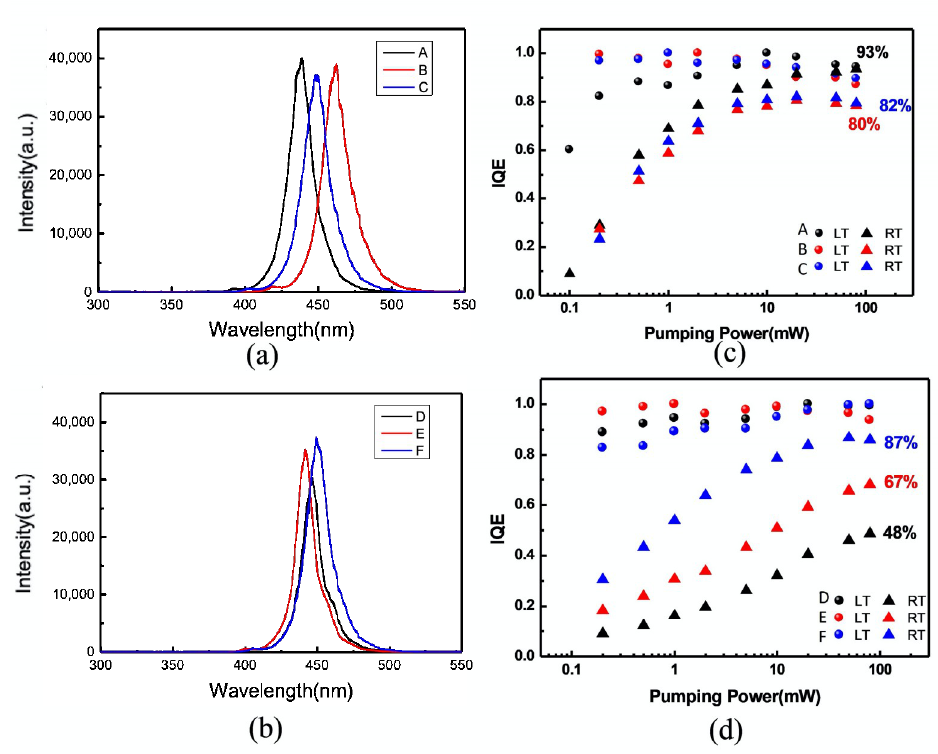
Figure 5. PL spectra of samples ( a ) A/B/C and ( b ) D/E/F. Normalized internal quantum efficiency (IQE) values of MQWs as a function of pumping power at 12 K and 300 K of samples ( c ) A/B/C and (d)